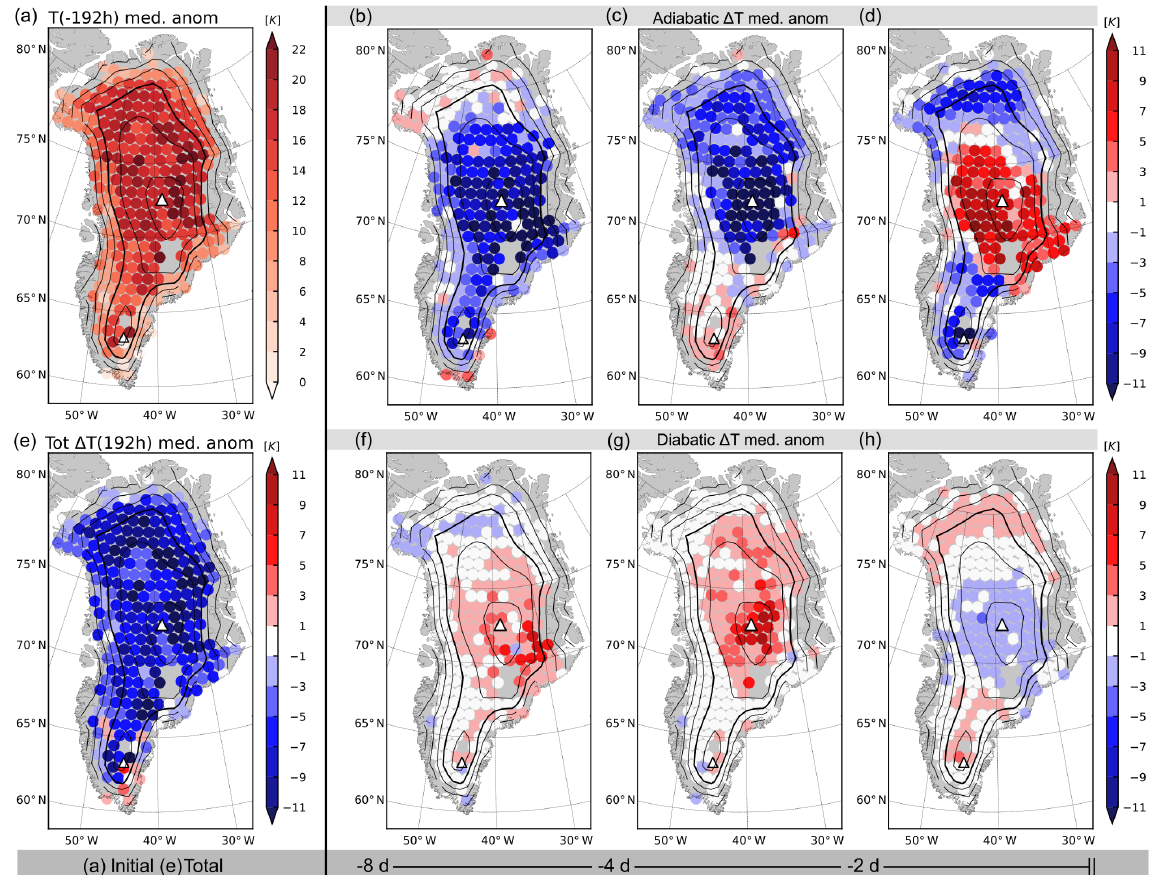
Figure 5. LFP anomaly maps of the (a) initial temperature at t = − 192h, and (b–d) adiabatic, (f–h) diabatic, and (e) total temperature change over 8d with respect to the climatological summertime air masses shown in Fig. 4. The adiabatic and diabatic temperature change anomalies are split up in the periods (b, f) t = − 192 to t = − 96h, (c, g) t = − 96 to t = − 48h, and (d, h) t = − 48 to t =